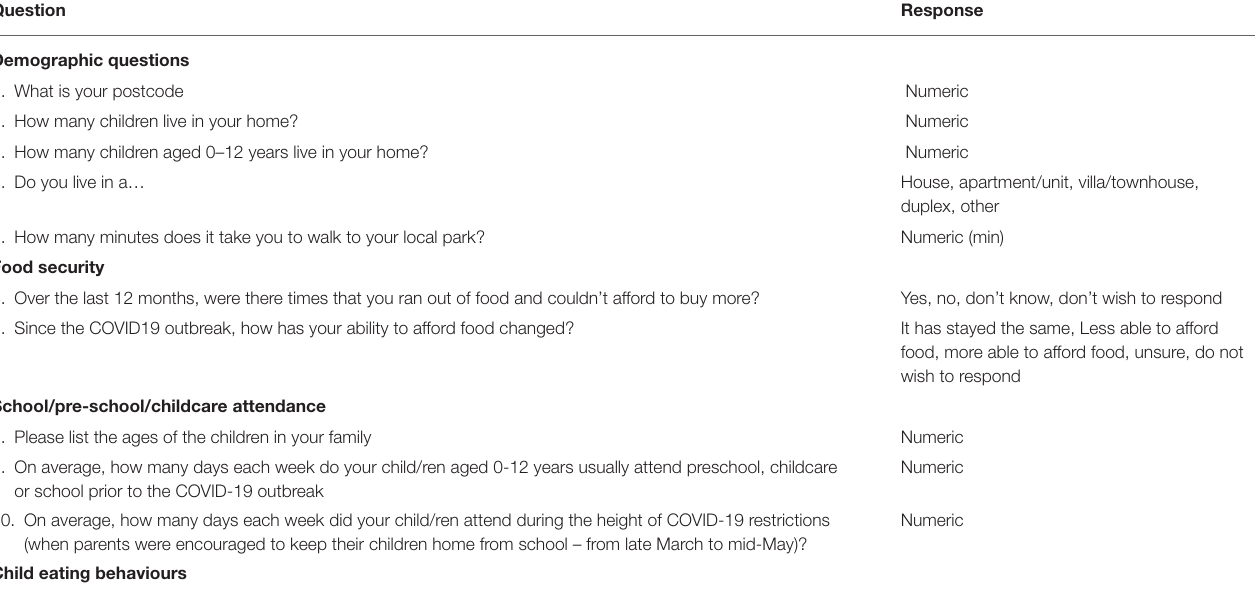
TABLE 1 | Items from